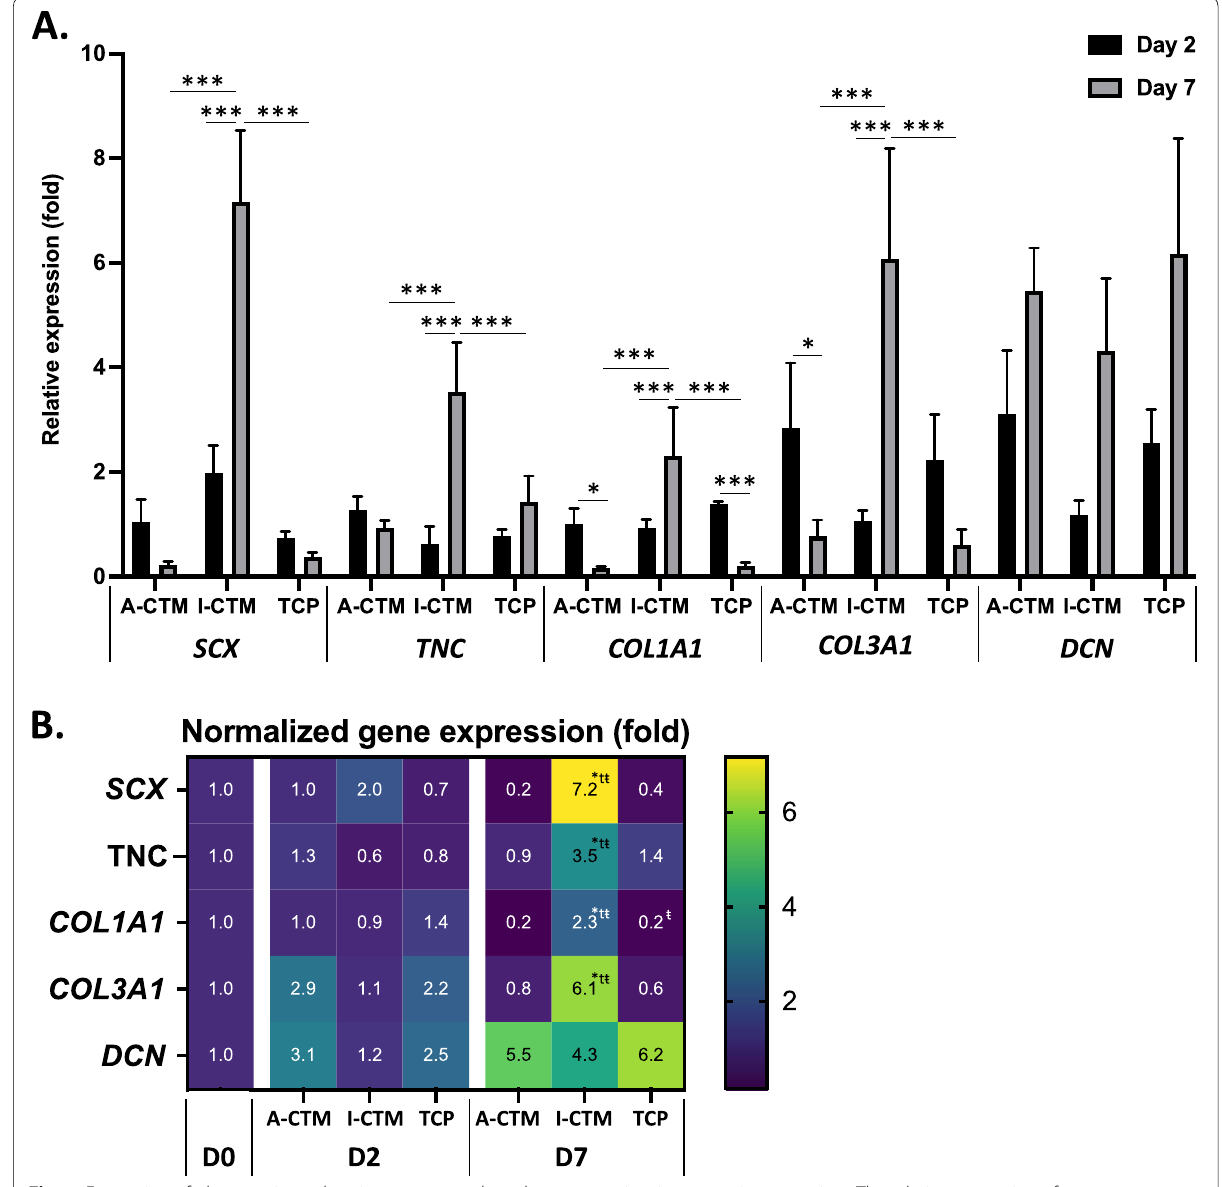
Fig. 5 Expression of phenotypic markers in tenocytes cultured on connective tissue matrices over time. The relative expression of tenocyte phenotypic markers (i.e., SCX , TNC , COL1A1 , COL3A1 , DCN ) in tenocytes cultured on A-CTM, I-CTM, and TCP for 2 and 7 days is shown. The relative expression (fold) was compared to the mRNA level in tenocytes on Day 0 (starting cells). Data are plotted as a bar graph ( A ) and as a heat map ( B ). Data shown are mean SD ( n 4 for cells on connective tissue matrices, n 3 for cells on TCP). A * p 0.05, ** p 0.01, *** p 0.005. B * p 0.05, ± = = ≤ ≤ ≤ ≤ compared with A-CTM; t p 0.05, compared with TCP; ŧ p 0.05, compared with day 2. Abbreviations: A-CTM, AmnioFill ® connective tissue ≤ ≤ matrix; COL1A1 , type I collagen; COL3A1 , type III collagen; DCN , decorin; I-CTM, Interfyl ® connective tissue matrix; SCX , scleraxis; TCP, tissue